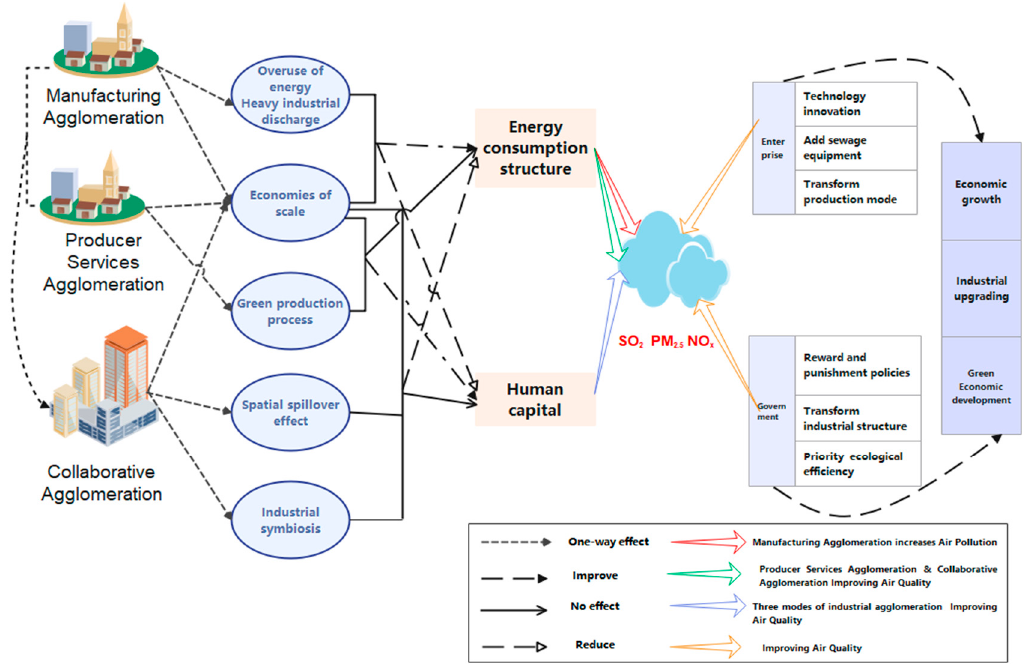
Figure 4. Route map of the industrial agglomeration effects on the atmospheric environment.